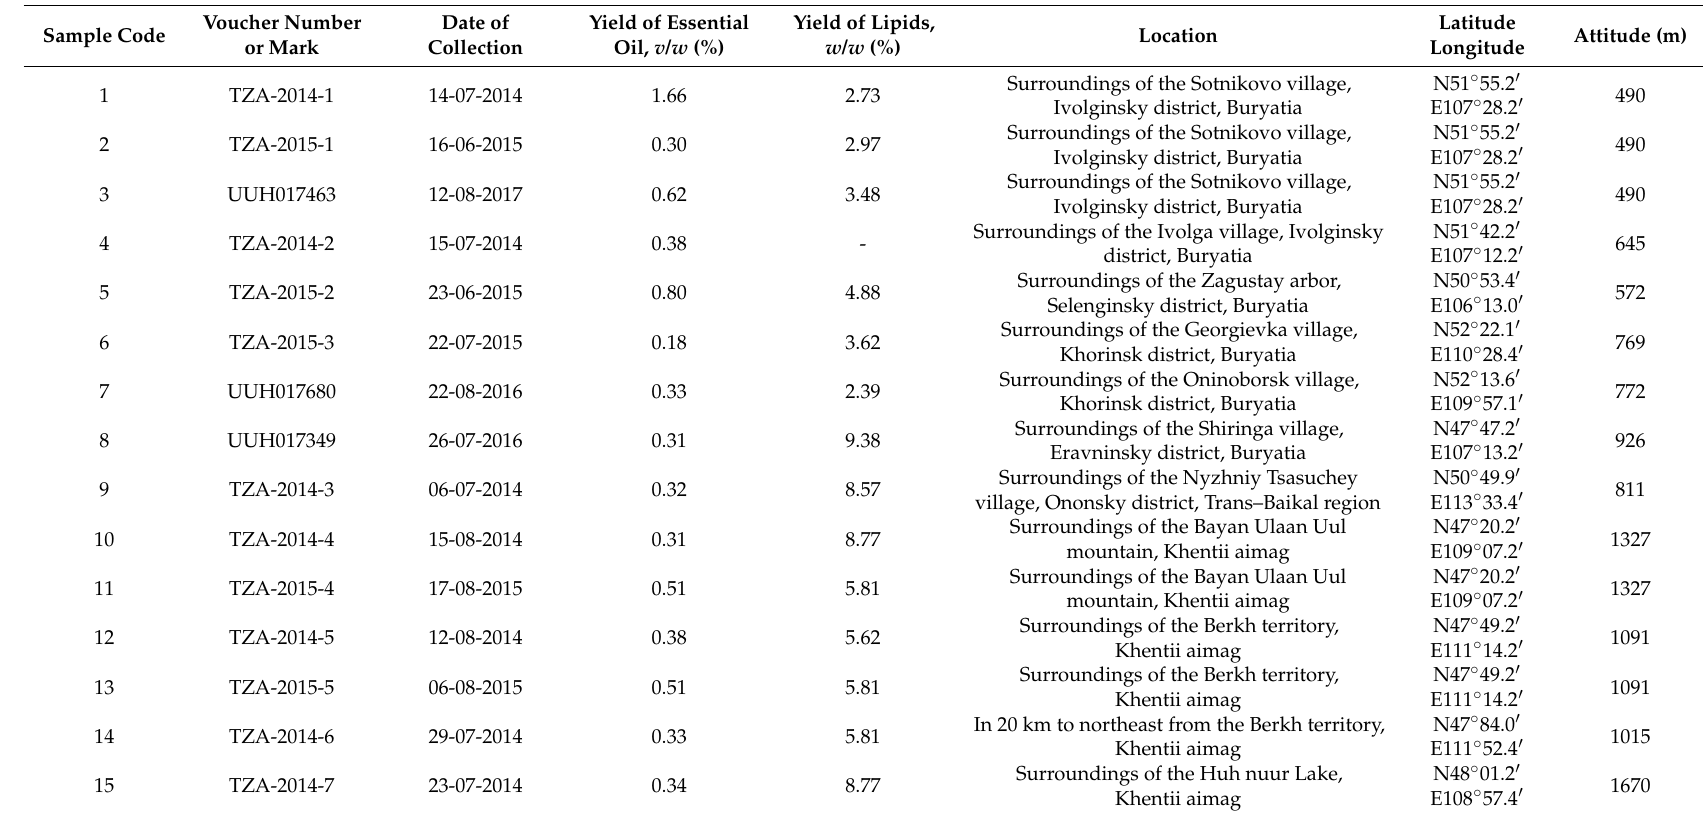
Table 3. Characteristics of Bupleurum scorzonerifolium Willd.